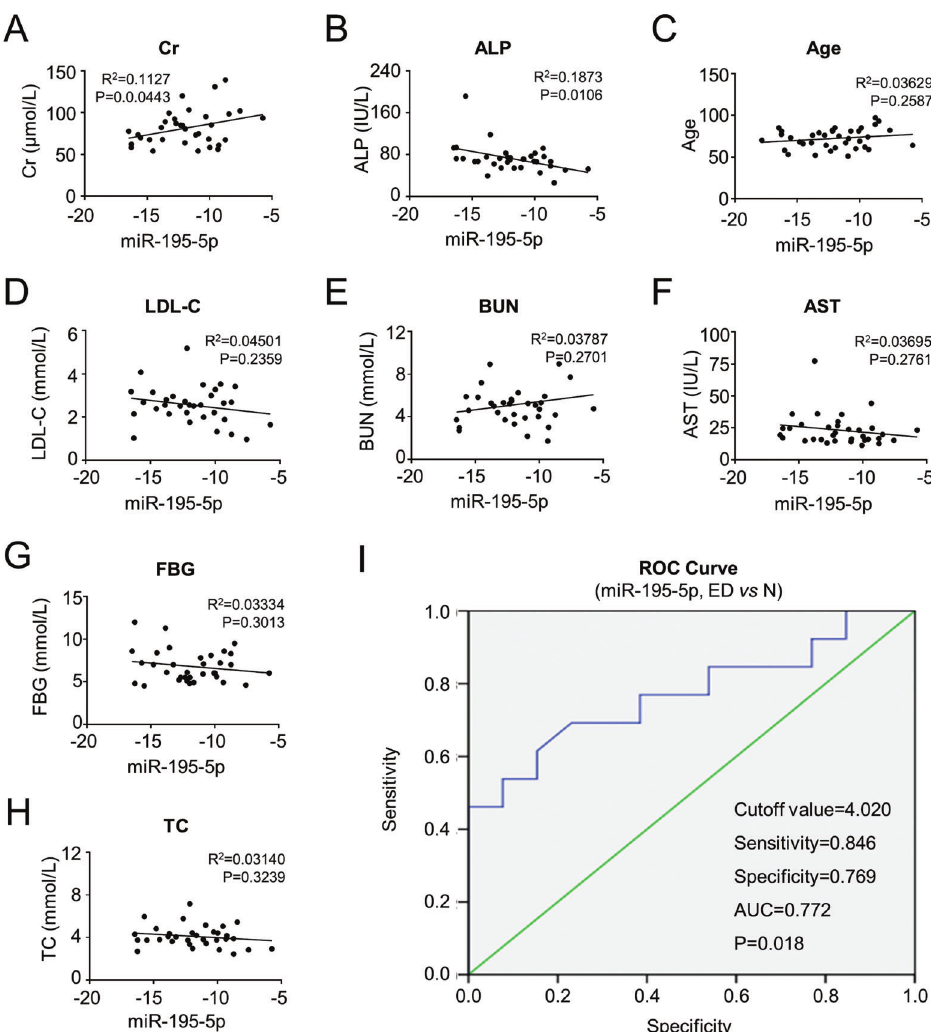
Figure 6 - Relevance of miR-195-5p with multiple clinicopathological parameters. A-B The relevance of miR-195-5p with positively related ED-associated clinicopathological parameters, including the Cr ( A ) and ALP ( B ). C Relevance of miR-195-5p with age. D-H MiR- 195-5p showed no significant difference with other ED-associated clinicopathological parameters, including LDL-C ( D ), BUN ( E ), AST ( F ), FBG ( G ), and TC ( H ). I ROC analysis of miR-195-5p between N and ED groups. Cut-off value=4.020, Sensitivity=0.846, Specificity=0.769, AUC=0.772, p